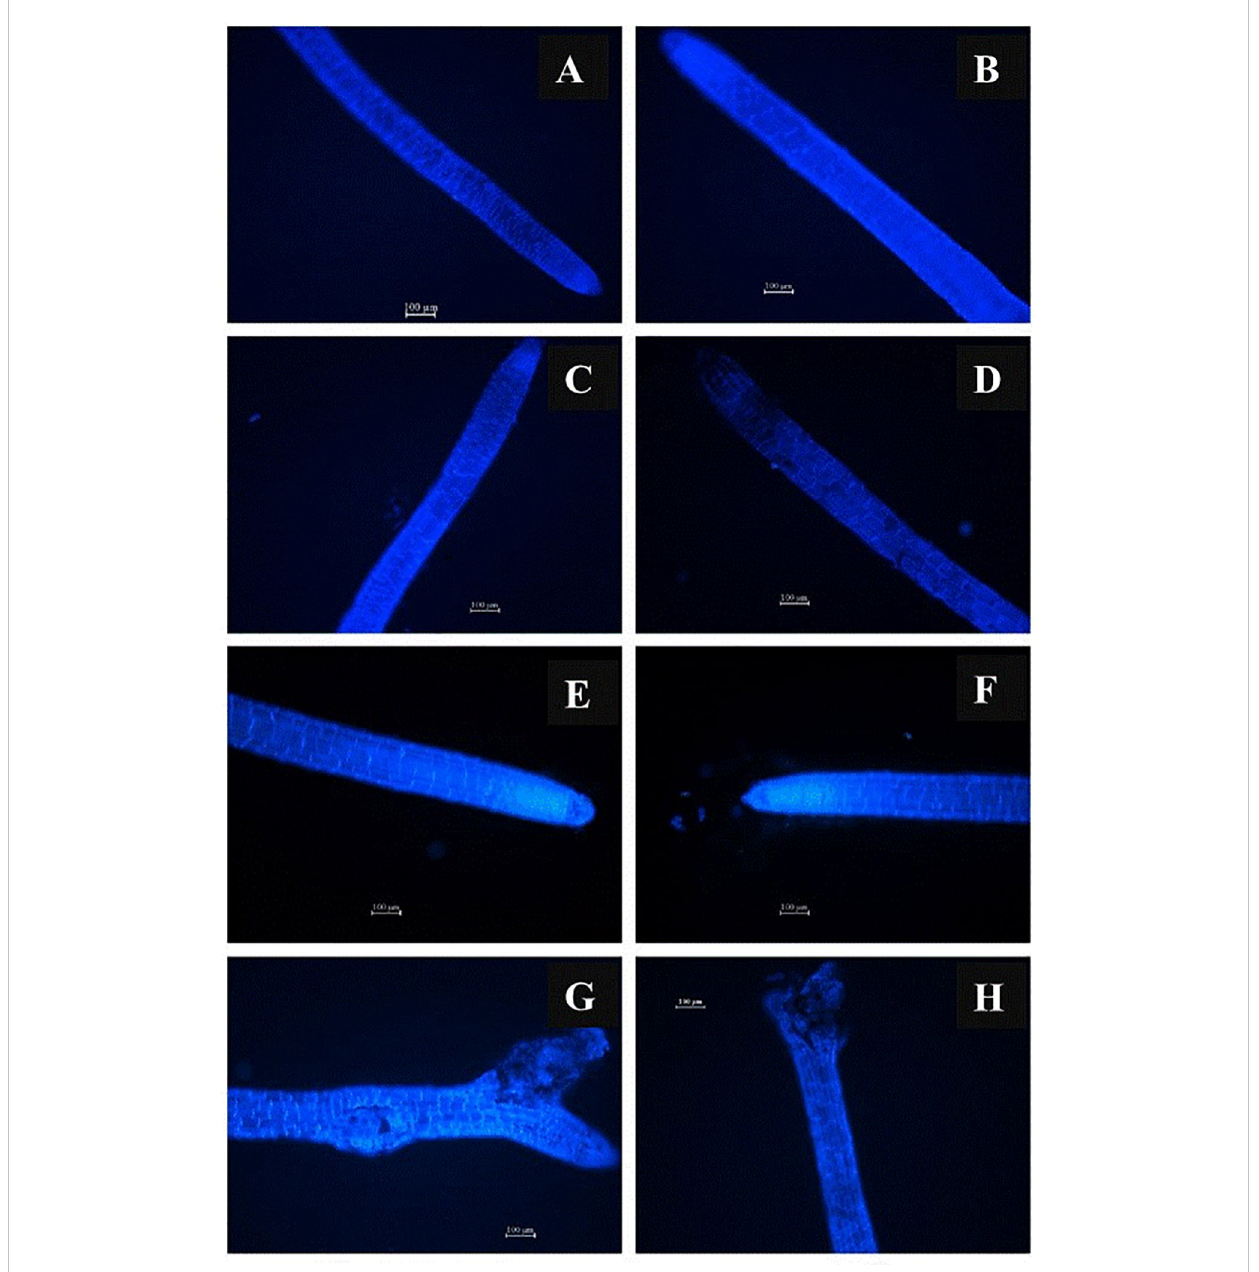
FIGURE 2 Representative 1-cm samples of roots including the tip and the elongation zone were stained with Calco fl uor white and examined under a fl uorescence microscope. Southern highbush blueberry plants ( Vaccinium corymbosum , cv. Windsor) were cultured in nutrient solution with pH 4.5 containing 10 (A, E) or 100 mg L -1 Ca (B, F) , or pH 7.5 containing 10 (C, G) or 100 mg L -1 Ca (D, H) for 1 day (A – D) and 3 days (E – H)